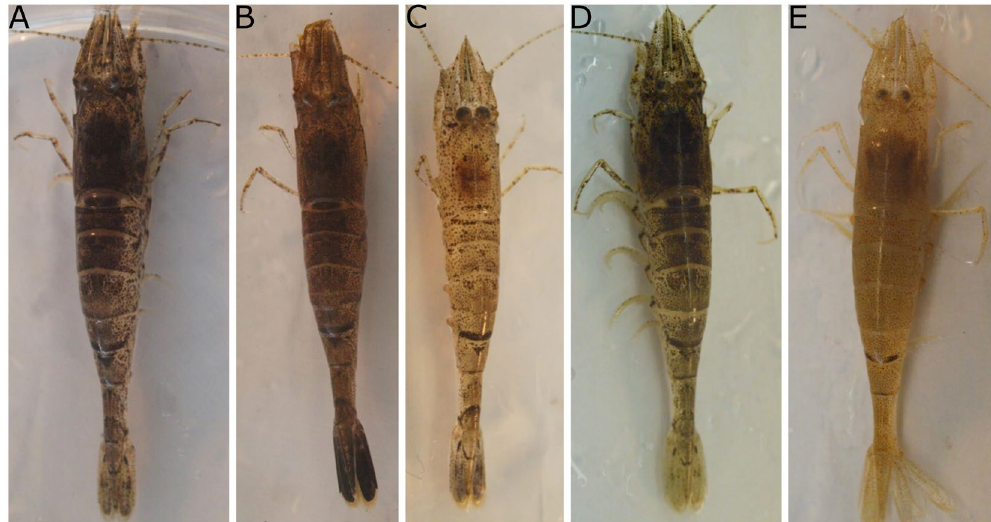
Figure 8. Examples of Crangon crangon ’s variation in natural colouration. Specimens were caught in the beach in front of Dale, Pembrokeshire, in the Cleddau Ddu estuary. ( A – C ) shrimp collected from muddy-sandy substrates; ( D ) shrimp collected from algae-dominated sand; ( E ) shrimp hold in a yellow bucket (notice the high spread of yellow pigments in